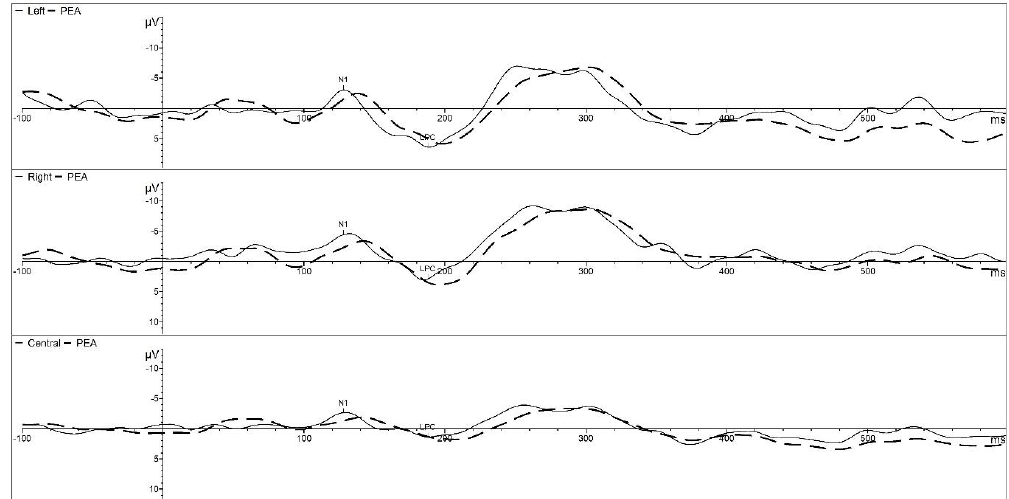
Figure 2. Example of olfactory event-related potentials (OERPs): comparison of two different concentrations of Phenethyl alcohol (PEA) in the right, left, and central regions of interest (ROI). PEA smell is considered to be an odourant that does not elicit a trigeminal stimulation. The solid line refers to the highest concentration of PEA. The dashed line refers to the lower PEA concentration. N1 is the first negative component, LPC is the late positive component.